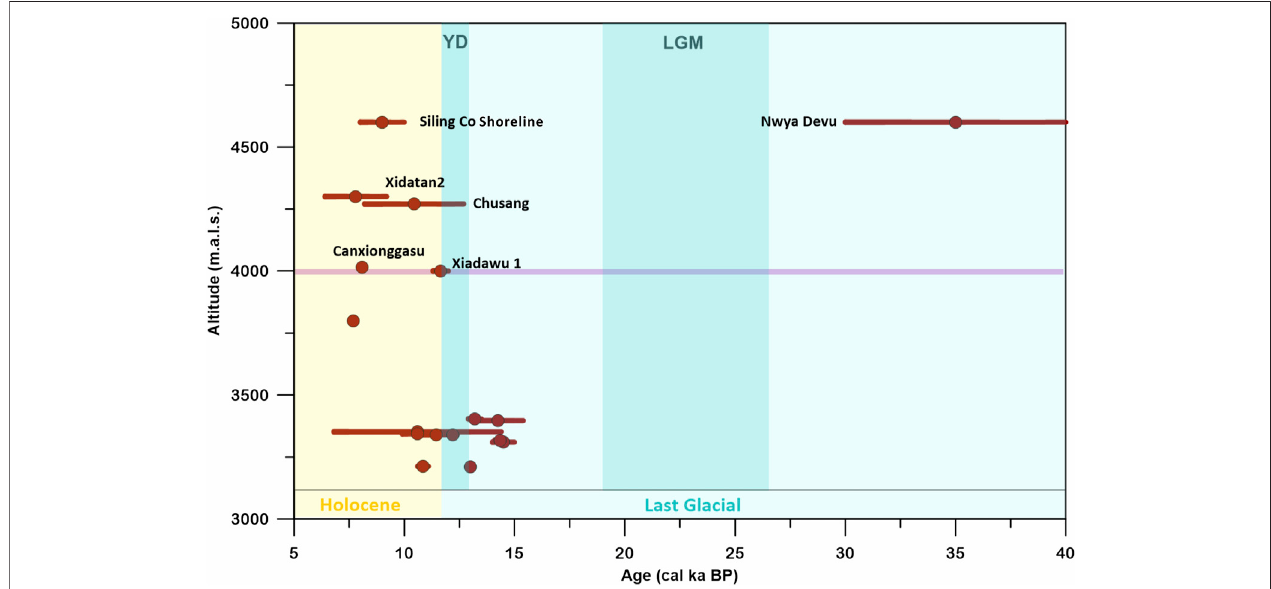
FIGURE5| Theagesandaltitudesofpaleolithic – microlithicsitesontheTibetanPlateau.Thenamesofstiesatelevation > 4,000 m(pinkline)areindicated.Notethat the Siling Co shoreline age here represents the maximum age of the Siling Co site.